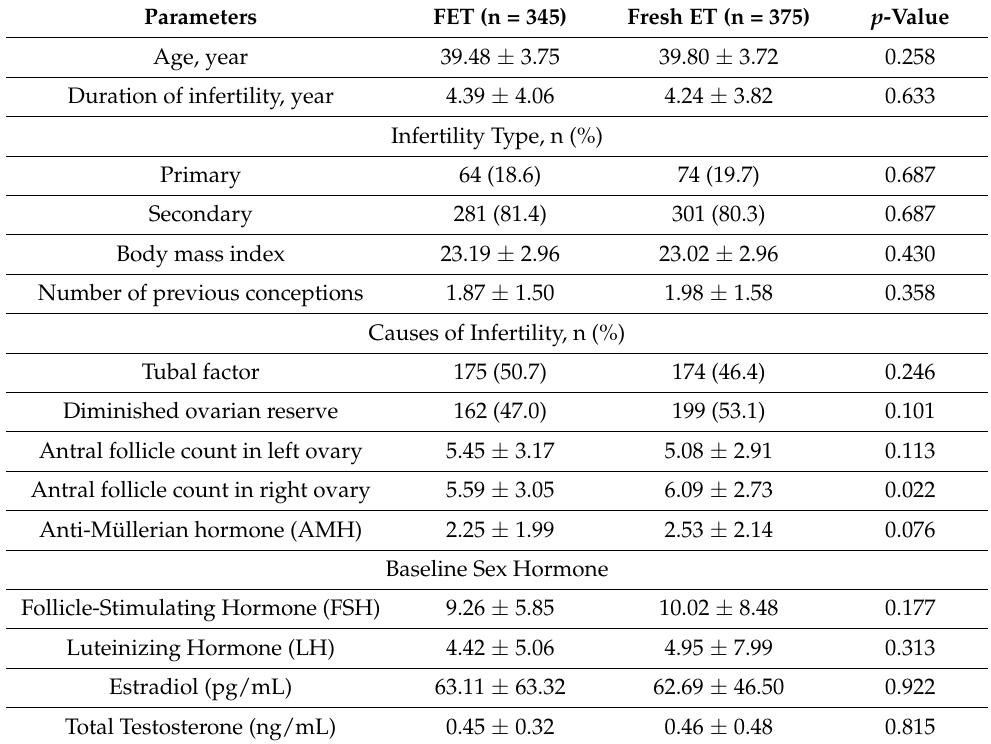
Table 1. Baseline characteristics of the FET group and fresh ET